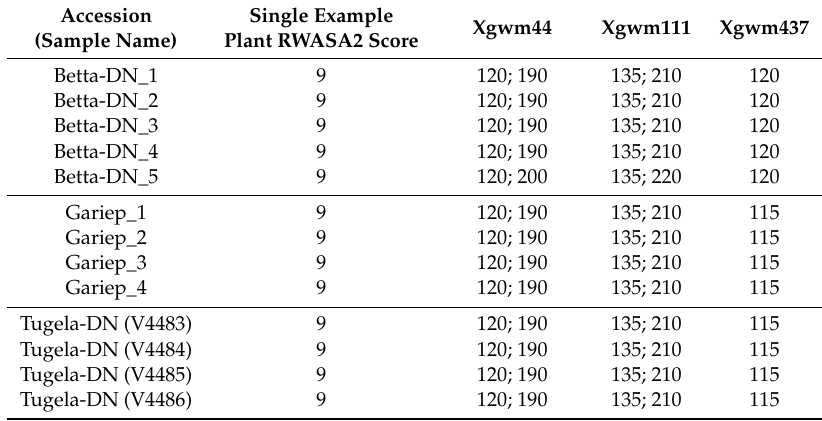
Table 3. Accession (Sample name), D. noxia damage score (RWASA2) and marker haplotype for